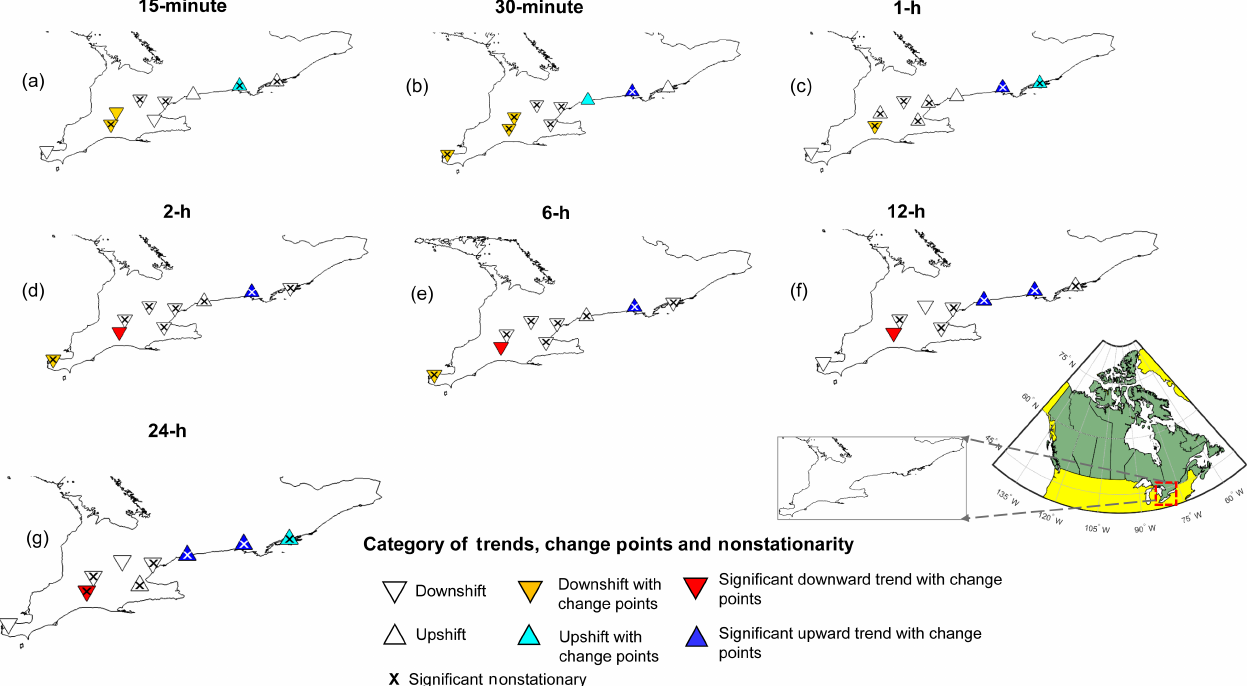
Figure 3. Spatial distribution of trends, change points, and nonstationarities in rainfall extremes of several durations in nine urbanized locations, Southern Ontario (a–g) . The up and down triangles in white indicate (statistically insignificant) upward and downward shifts; the up and down triangles in cyan and orange indicate shifts with change points only; the up and down triangles in dark blue and red show the presence of (statistically significant) trends, including change point(s). A “ × ” symbol in the triangle indicates nonstationarity detected through Priestley and Subbarao test statistics. All tests are performed at 10% significance levels, i.e. p value < 0 .